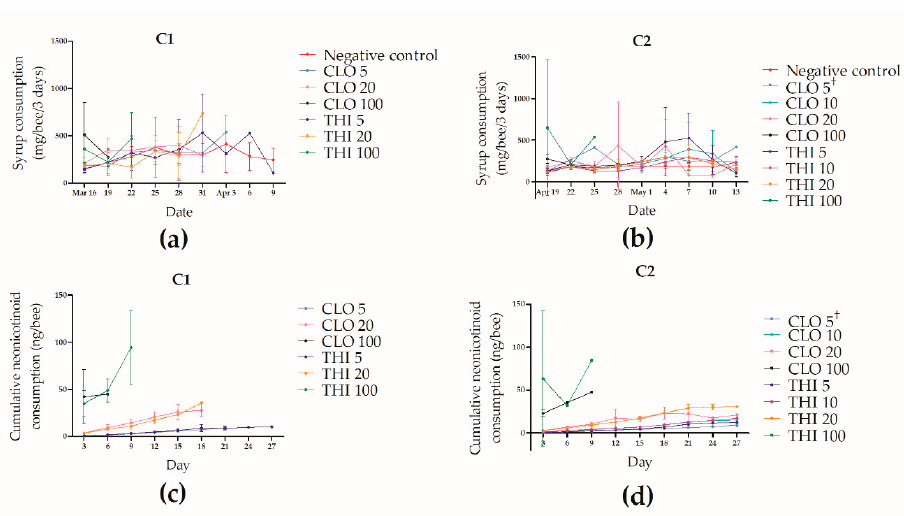
Figure 9. Laboratory syrup consumption and cumulative neonicotinoid consumption of winter adult Apis mellifera workers. Winter workers were exposed to thiamethoxam (THI) or clothianidin (CLO) (doses in ng / g) for 30 days, through syrup, and mortality was monitored daily. Two laboratory cage trials were conducted: C1 in March–April, 2018 ( a , c ) and C2 in April–May, 2018 ( b , d ). Only C2 included 10 ng / g dose groups. Lines indicate mean syrup consumption in mg per bee per three days ( a , b ) and mean cumulative neonicotinoid consumption in ng per bee ( c , d ). † Consumption data for day six were missing for the CLO 5 group in C2.